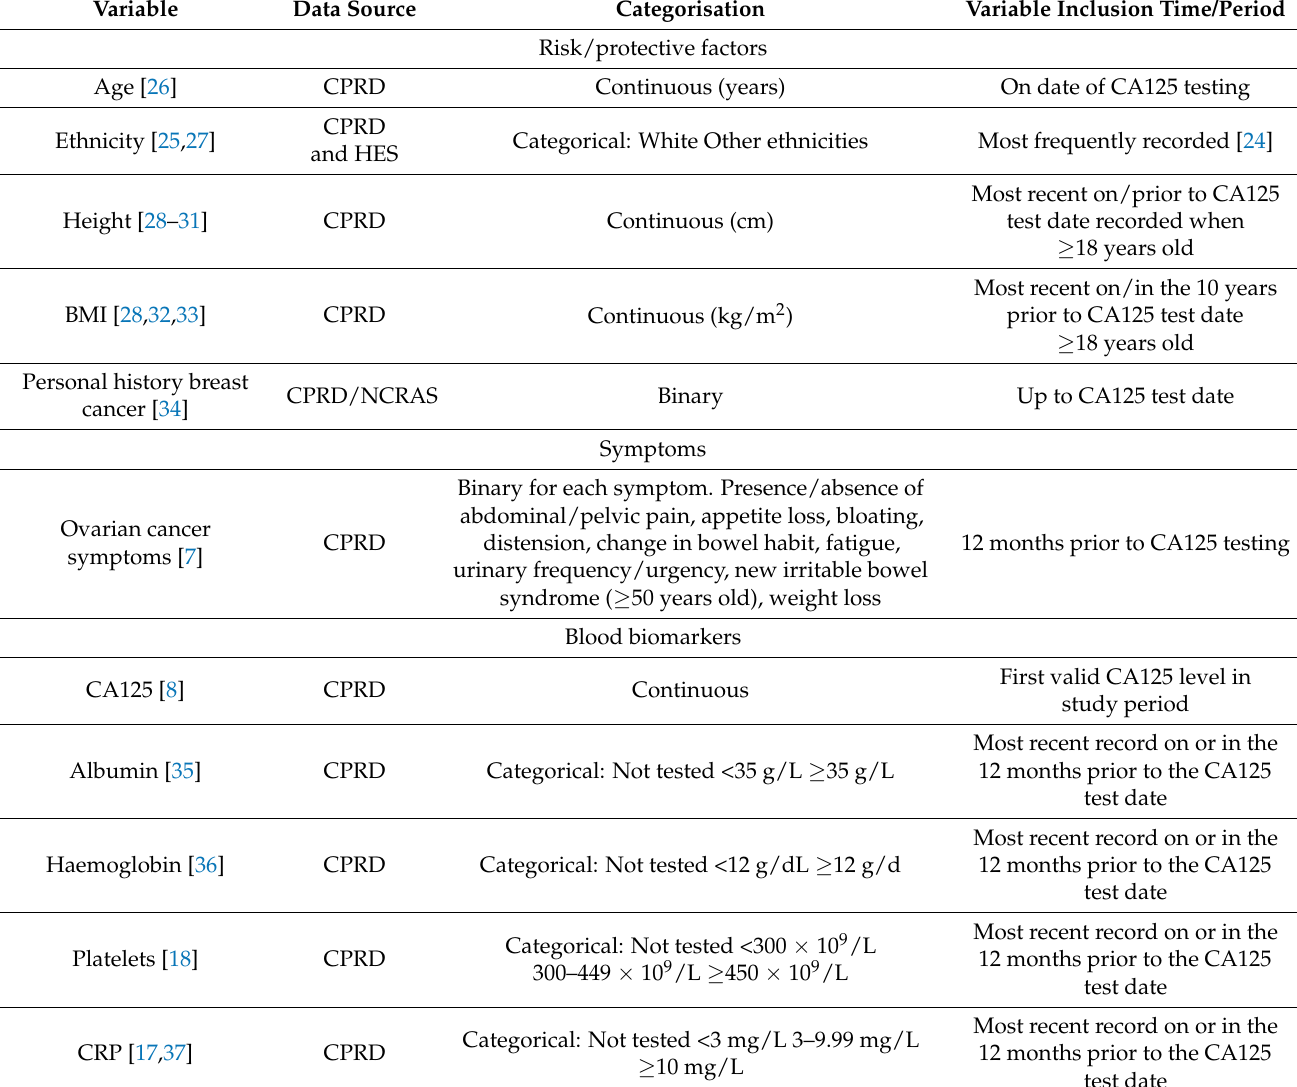
Table 1. Candidate